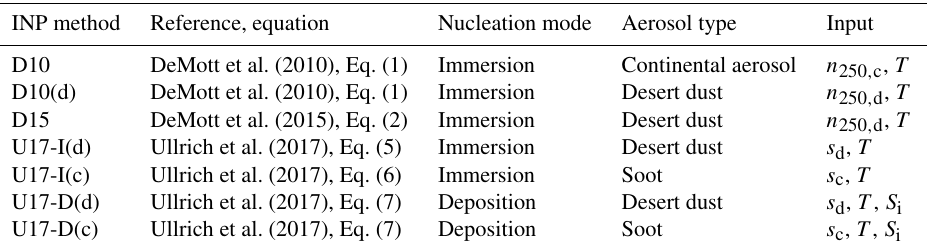
Table 1. INPC parameterizations used in our study and taken from the literature (reference and specific equation in this reference). Details of the lidar-based method to estimate INPC profiles can be found in Mamouri and Ansmann (2016) and Marinou et al. (2019). Input parameters in the INPC estimation are the particle number concentrations n 250 , d and n 250 , c , the particle surface area concentrations s d and s c , and temperature T . Indices d and c denote dust particles and continental pollution particles (e.g., haze and smoke). The D15 INPC parameterization is used with a factor (cf. Eq. (1) in D15) of 1.0 in our study instead of 3.0 as applied in the original equation (DeMott et al., 2015). In the U17-D INP parameterization the ice supersaturation value S i has to be